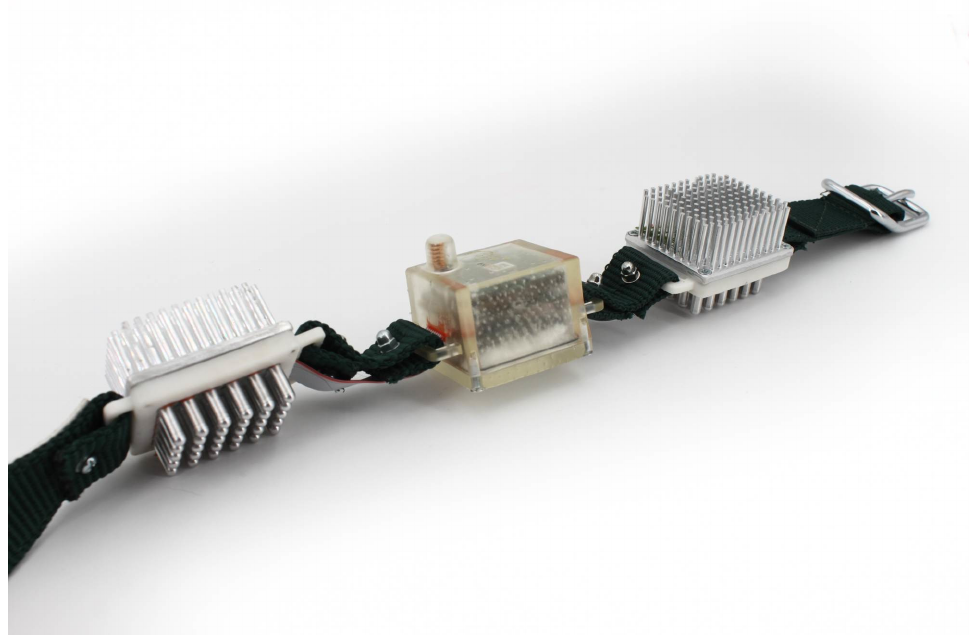
Figure 1. The tracker is implemented as a collar that can be attached to the desired animal. Two of the three housings are dedicated to thermal energy harvesting. The remaining one contains the main